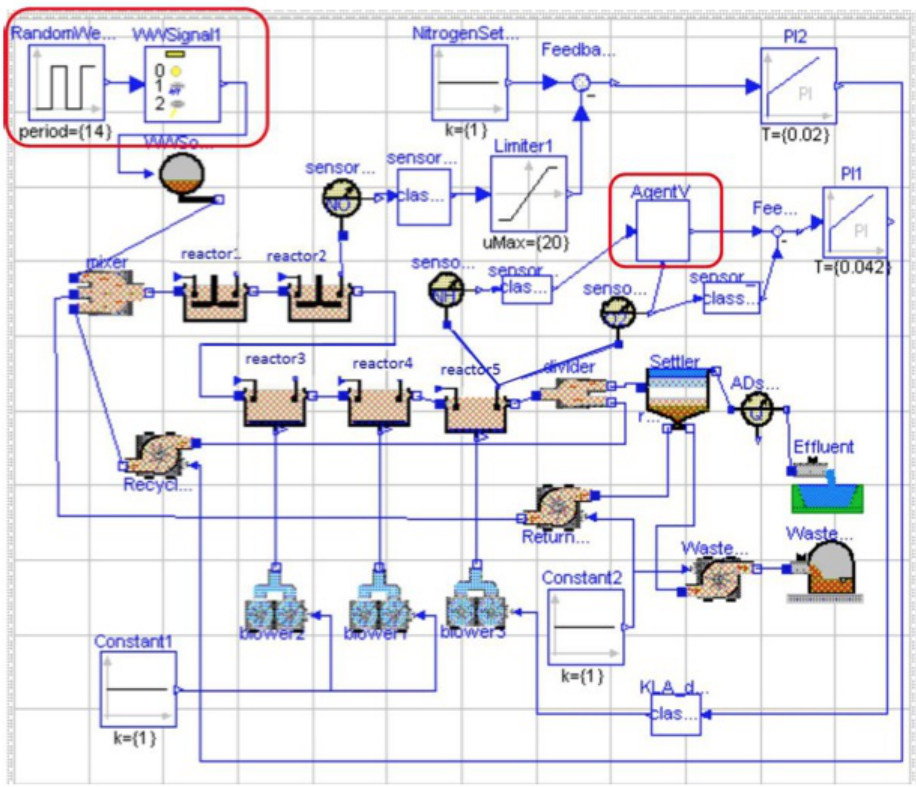
Figure 8. RL agent in